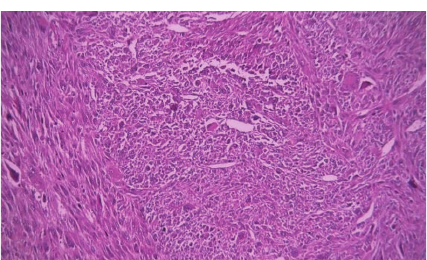
Figure 2: Hematoxylin and eosin stained section at 400x magni- fication demonstrating highly pleomorphic cells with prominent nucleoli in a storiform